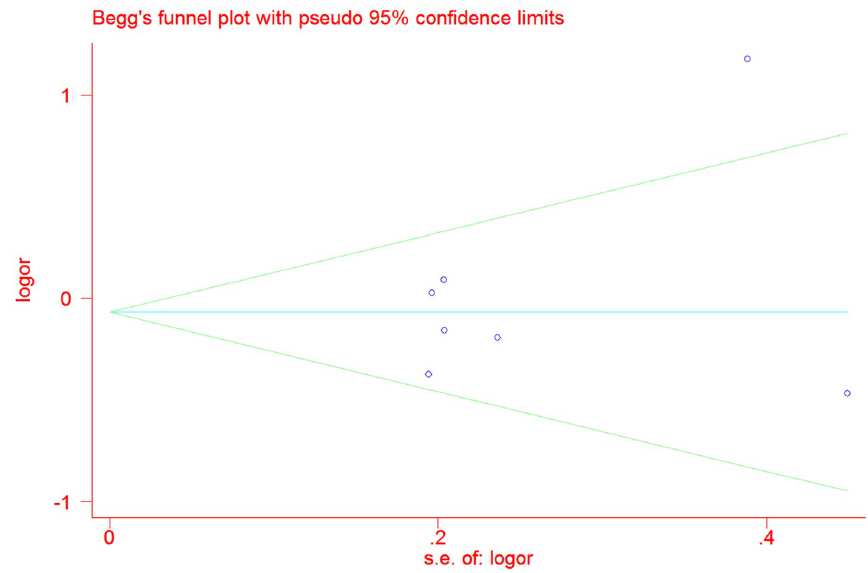
Fig 6. Funnel plot on publication bias for the associations between COL3A1 rs1800255 polymorphism and POP risk by allele contrast: A vs. G.